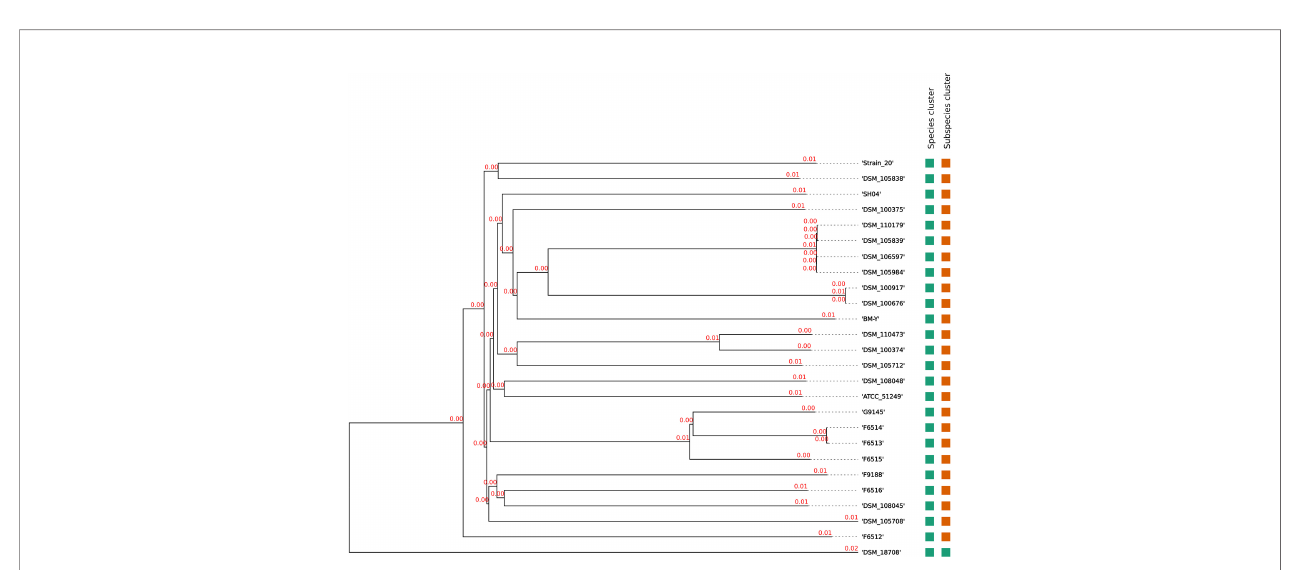
FIGURE 2 | Phylogenomic tree of the W. chitiniclastica species and subspecies delineation based on the GBDP phylogenetic analyses retrieved and modi fi ed based on the Type (Strain) Genome Server (TYGS). The tree was inferred with FastME 2.1.6.1 (Lefort et al., 2015) from GBDP distances calculated from genome sequences and was subjected to a clustering using established thresholds for delineating species (DDH > 70%) (Meier-Kolthoff et al., 2013) as well as subspecies (DDH > 79%) (Meier-Kolthoff et al., 2014). The branch lengths are scaled in terms of GBDP distance formula d5 and are represented in red numbers. The numbers above branches are GBDP pseudo-bootstrap support values >60% from 100 replications, with an average branch support of